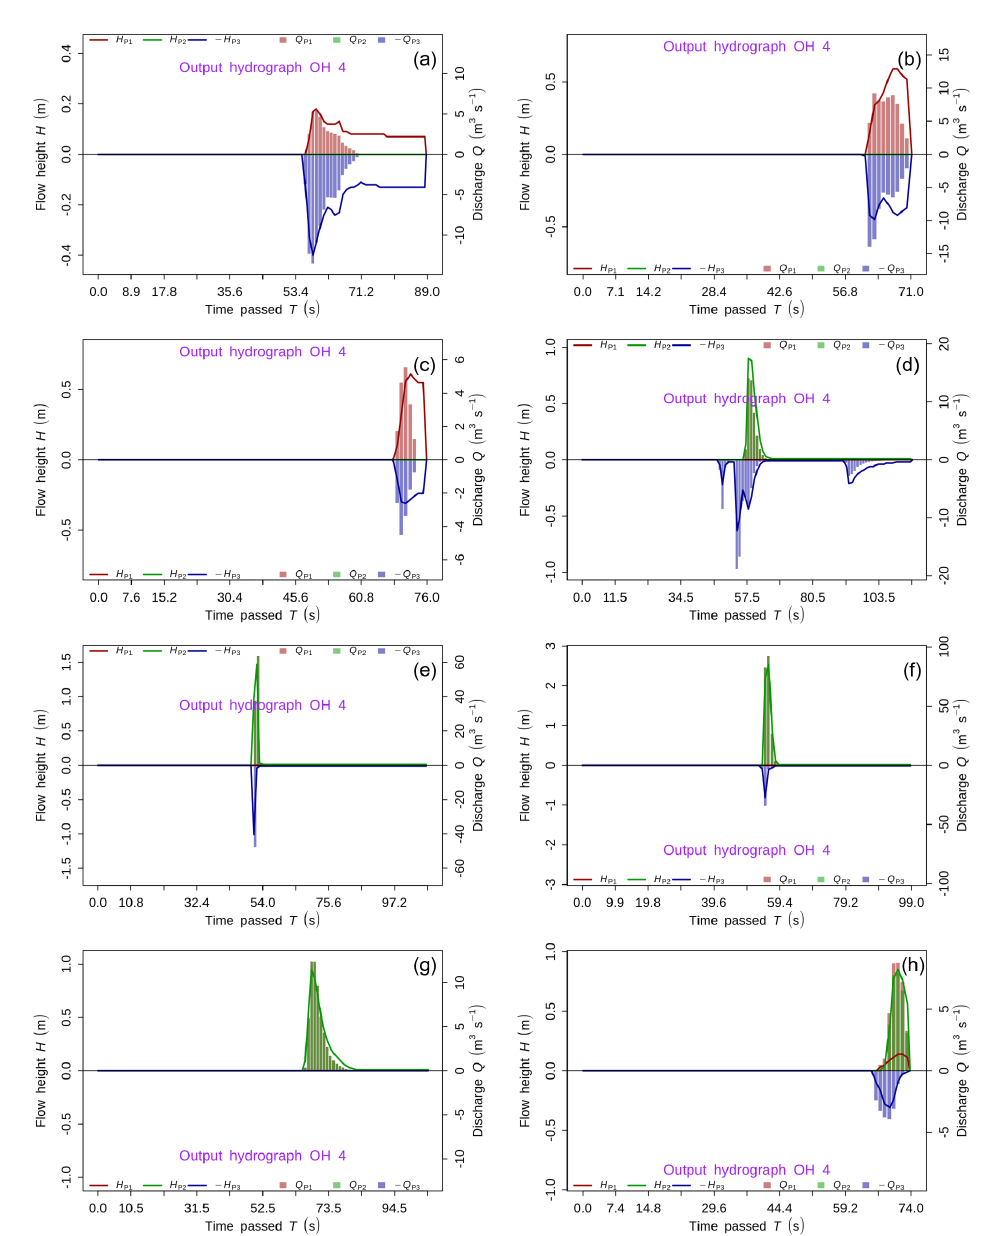
Figure 6. Flow discharge and height profile at 100 m away from the toe of the slope for ( a ) D3; ( b ) D5; ( c ) D7; ( d ) M3; ( e ) M5; ( f ) M7; ( g ) E1; ( h ) C1. The solid line represents the flow height and the bar chart the